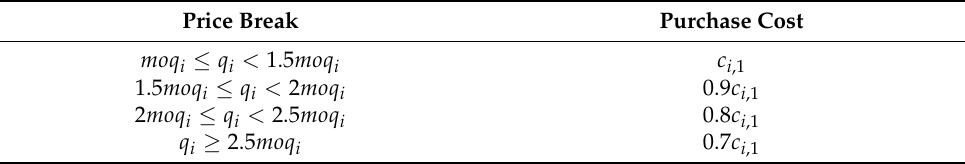
Table 4. Discount